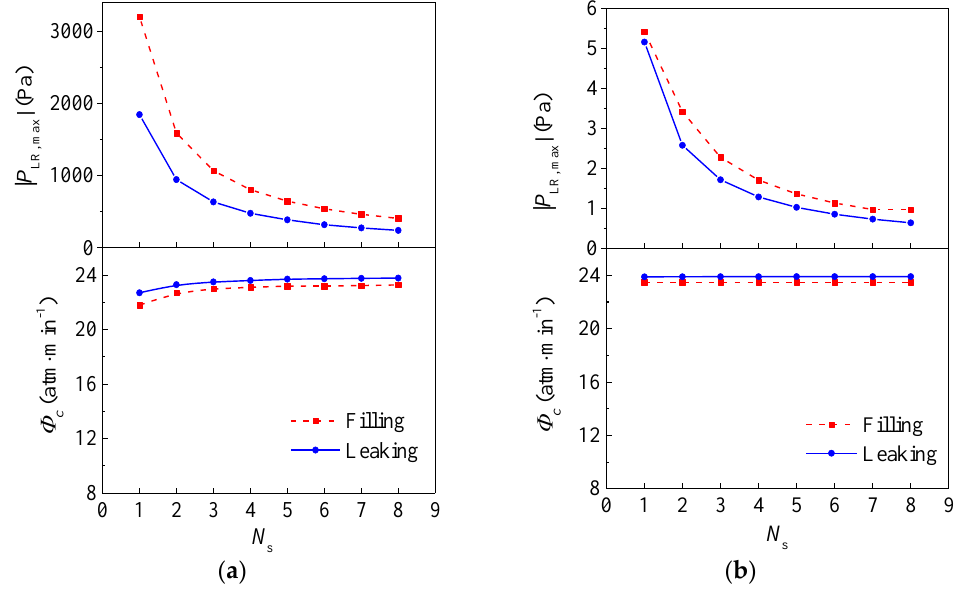
Figure 9. Effect of the number of the hole on the support tent N o on the critical pressure variation rate Φ c and the maximum pressure difference across the hole on the support tent Δ P LR, max . ( a ) d s = 50 μm; ( b ) d s = 0.2 mm.